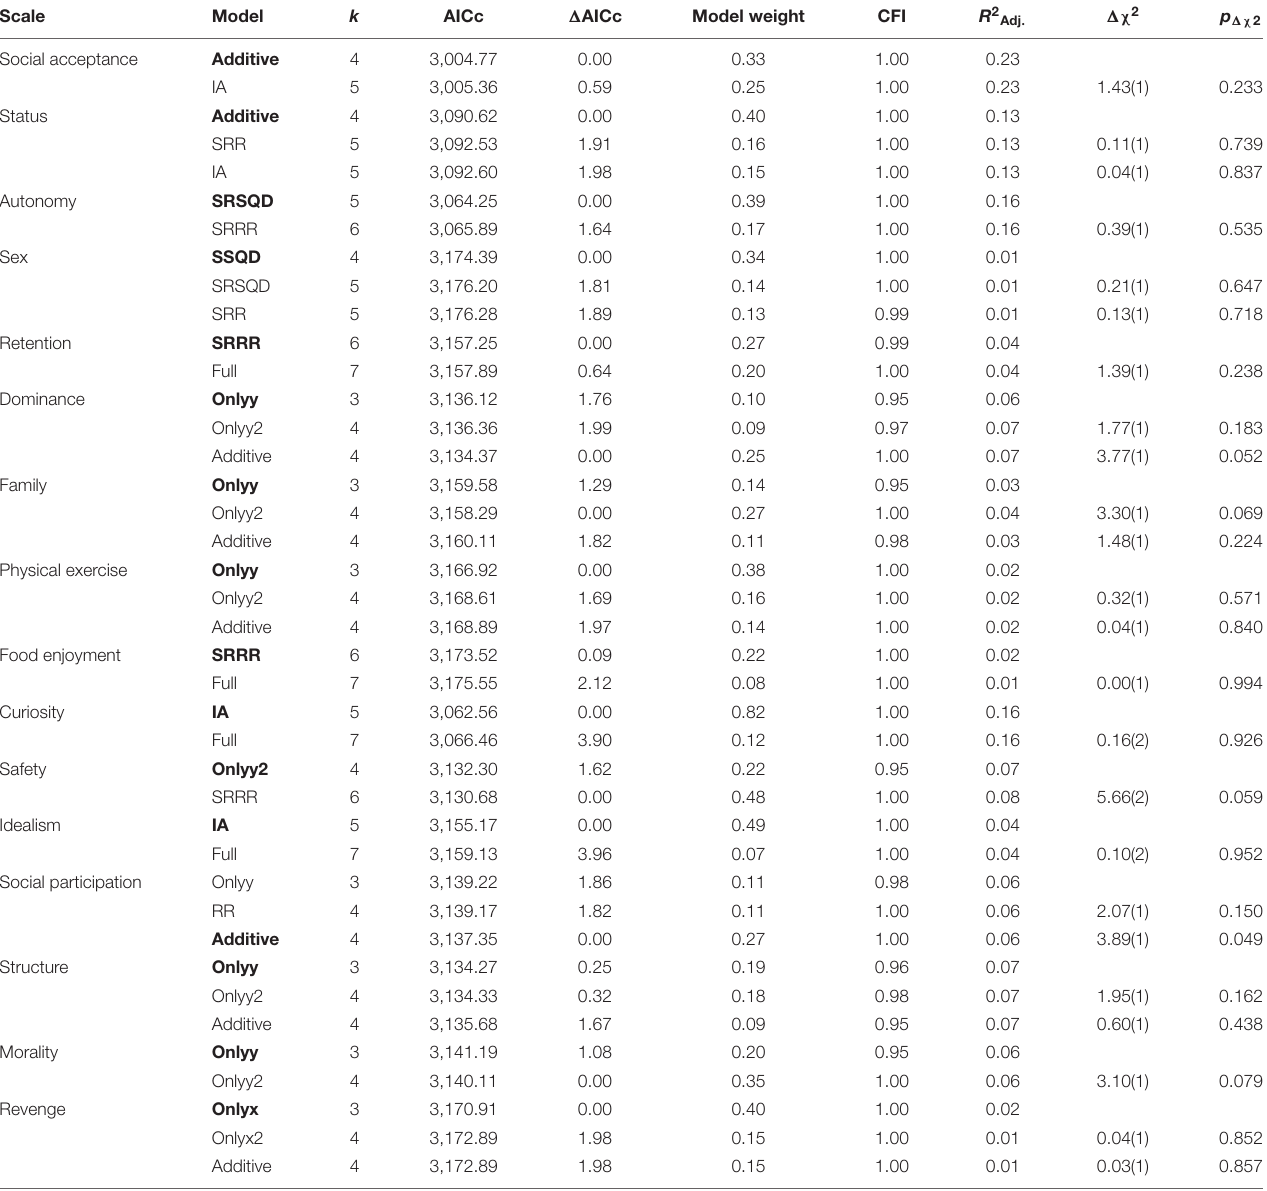
TABLE 3 | Results of the model selection